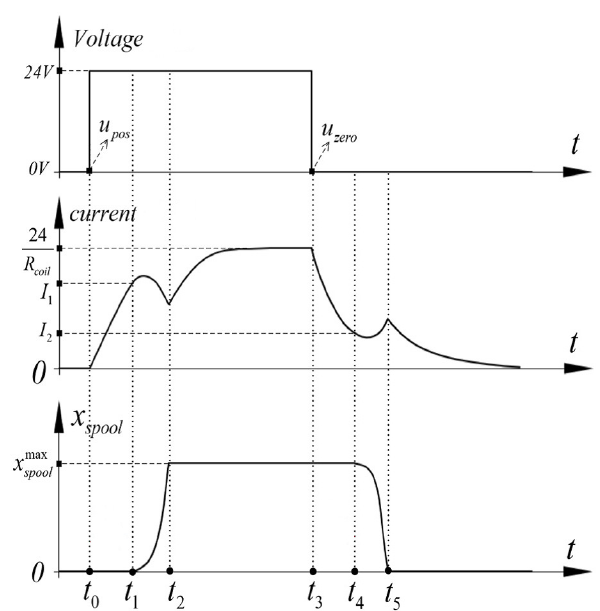
Figure 7. A typical response of a solenoid valve shows the excitation voltage, current, and displacement.